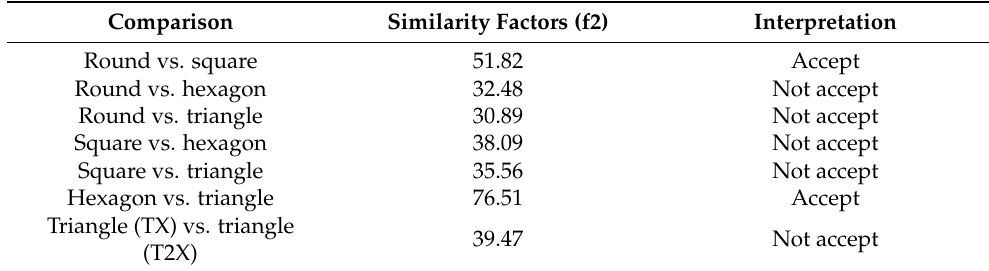
Table 4. Similarity factor ( f 2 ) results for dissolution profile comparison of FDP-loaded 3D-printed tablets. Comparison Similarity Factors (f2)